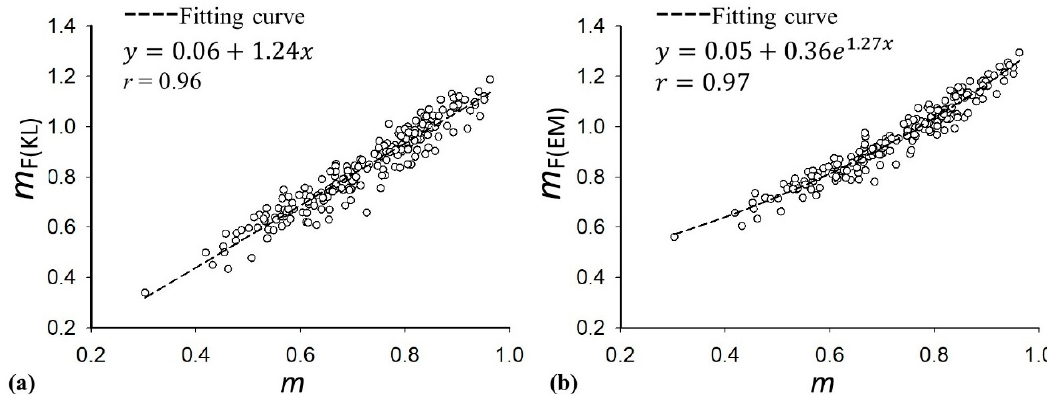
Figure 10. Comparisons of the m F(KL) and m F(EM) parameters with the m parameter. ( a ) m F(KL) ; ( b ) m F(EM) . The linear and exponential increasing functions were used for performing curve fitting. A nonlinear relationship between the m F(EM) and m parameters was found.